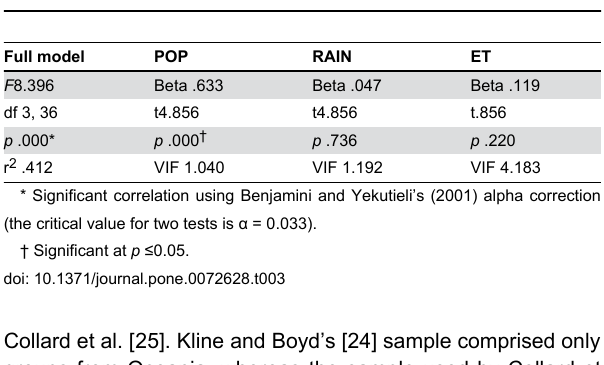
Table 3. Summary of results of standard multiple regression analysis carried out to assess the relative importance of population size (POP), mean annual rainfall (RAIN), and effective temperature (ET) as drivers of toolkit complexity (TTS) in a worldwide sample of nonindustrial food-producing societies (n =